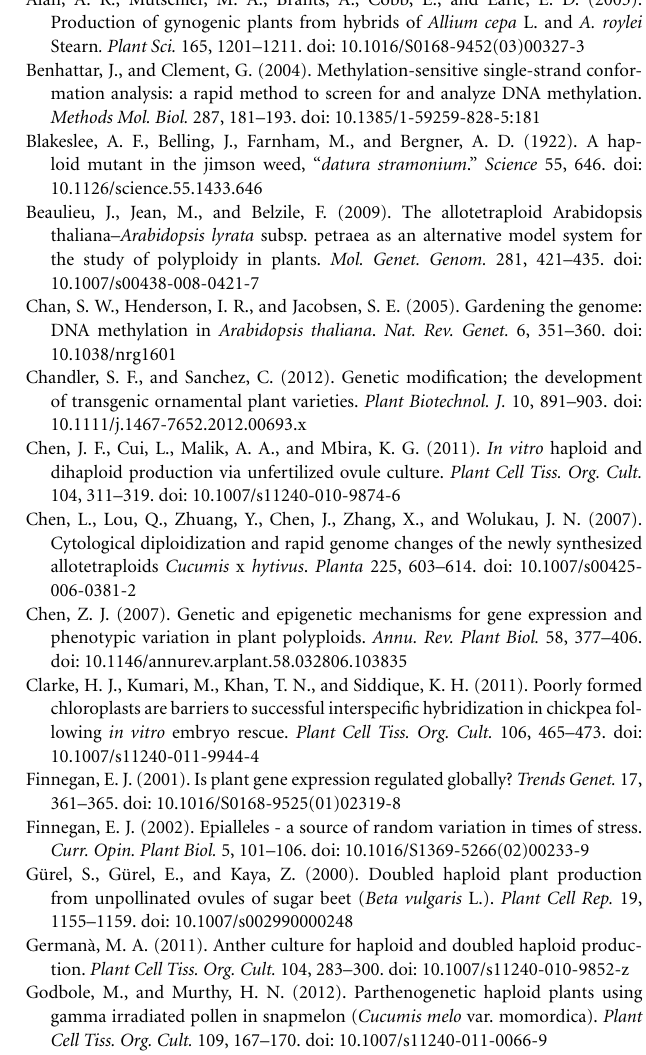
Supplementary Figure 1 | Examples of MSAP profiles implying cytosine methylation alterations between biological replicates. The Hpa II lanes involve the primer combination E4 + HM7, and the Msp I lanes E8+HM8. Hete: “Zhongshanzigui”; Ha: haploid; Di-ha: doubled haploid. Two individual plants from each line (one marked with an asterisk, the other not) were selected at